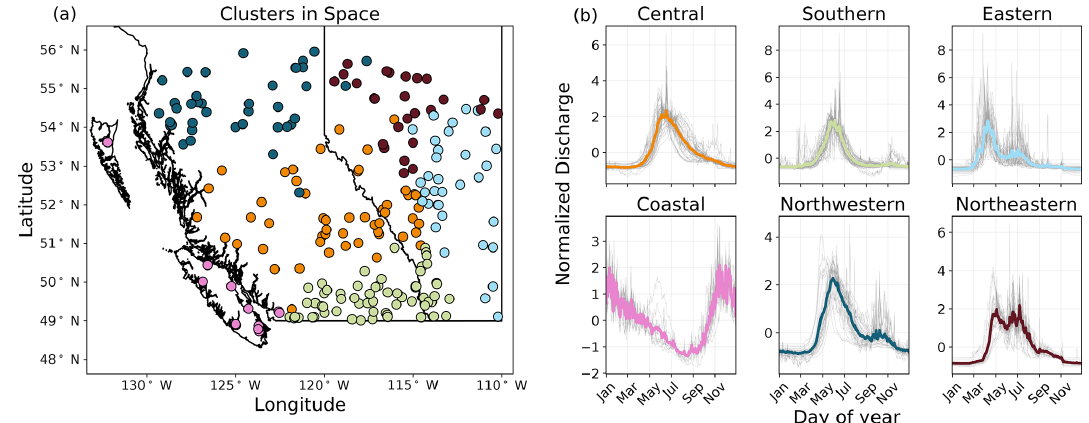
Figure 2. The seasonal streamflow cluster patterns and their locations in space. The colour of the stream gauge in the panel (a) corresponds to the climatological seasonal streamflow cluster pattern in panel (b) . The background grey curves in the cluster pattern plots (b) are the daily values of the climatological seasonal streamflow at the stream gauges in each cluster. Seasonal discharge of each station is normalized to have a mean of zero and unit